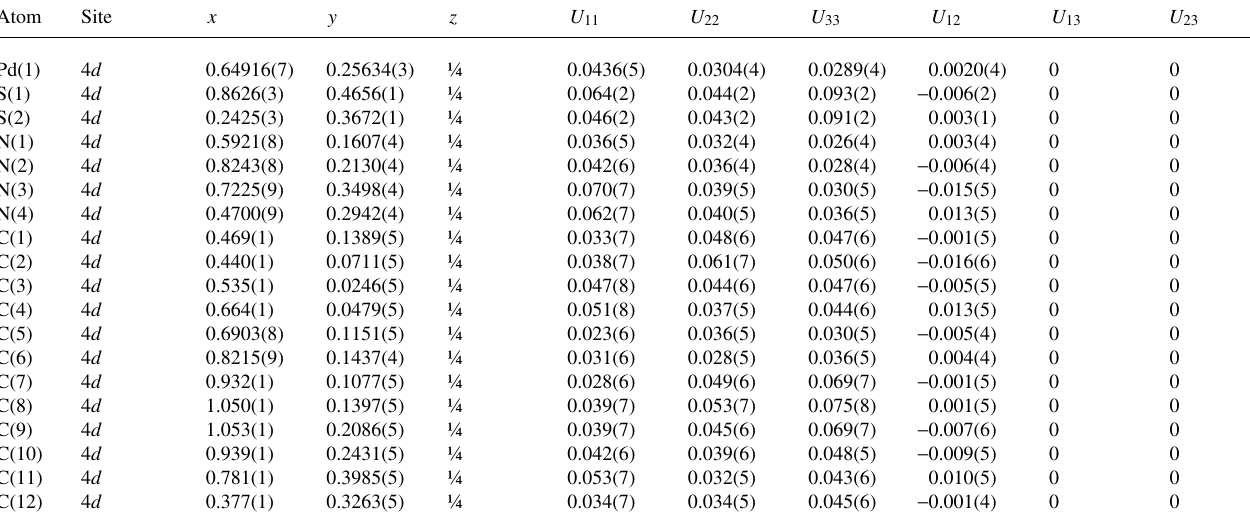
Table 3. Atomic coordinates and displacement parameters (in Å 2 )